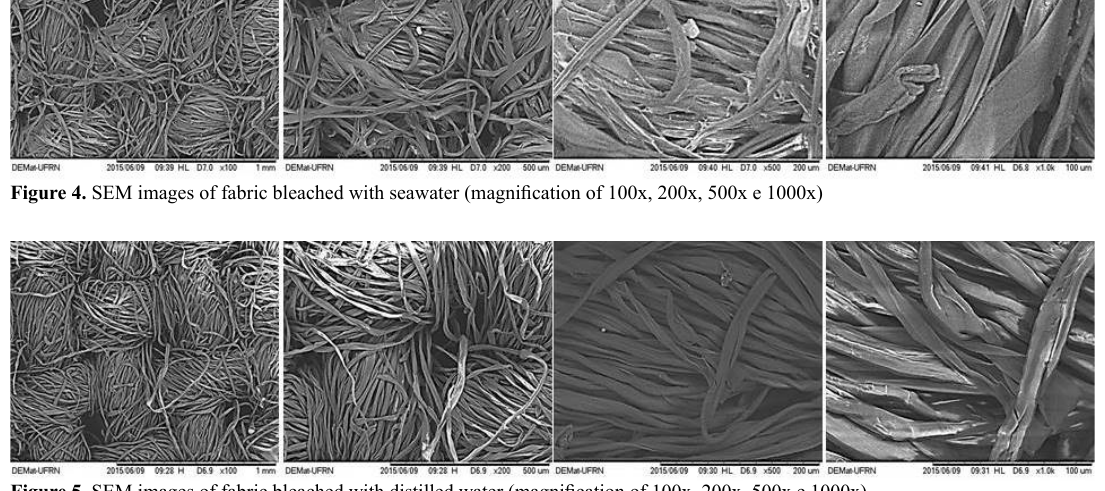
Figure 5. SEM images of fabric bleached with distilled water (magnification of 100x, 200x, 500x e